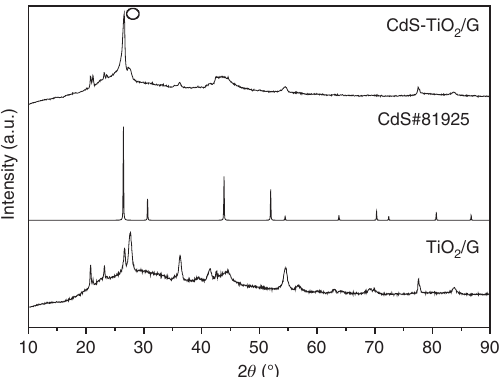
/G, which was synthesized 2